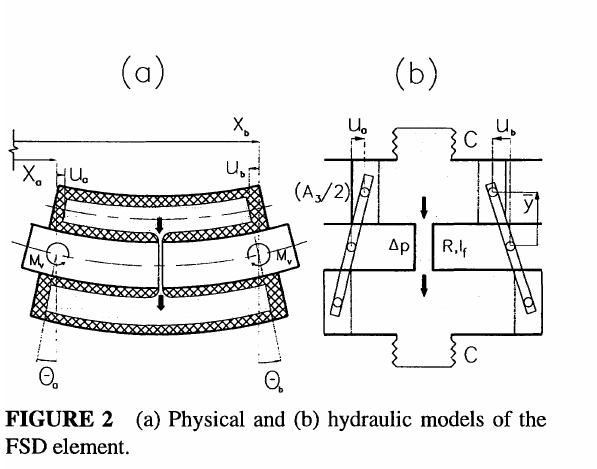
FIGURE 2 (a) Physical and (b) hydraulic models of the FSD